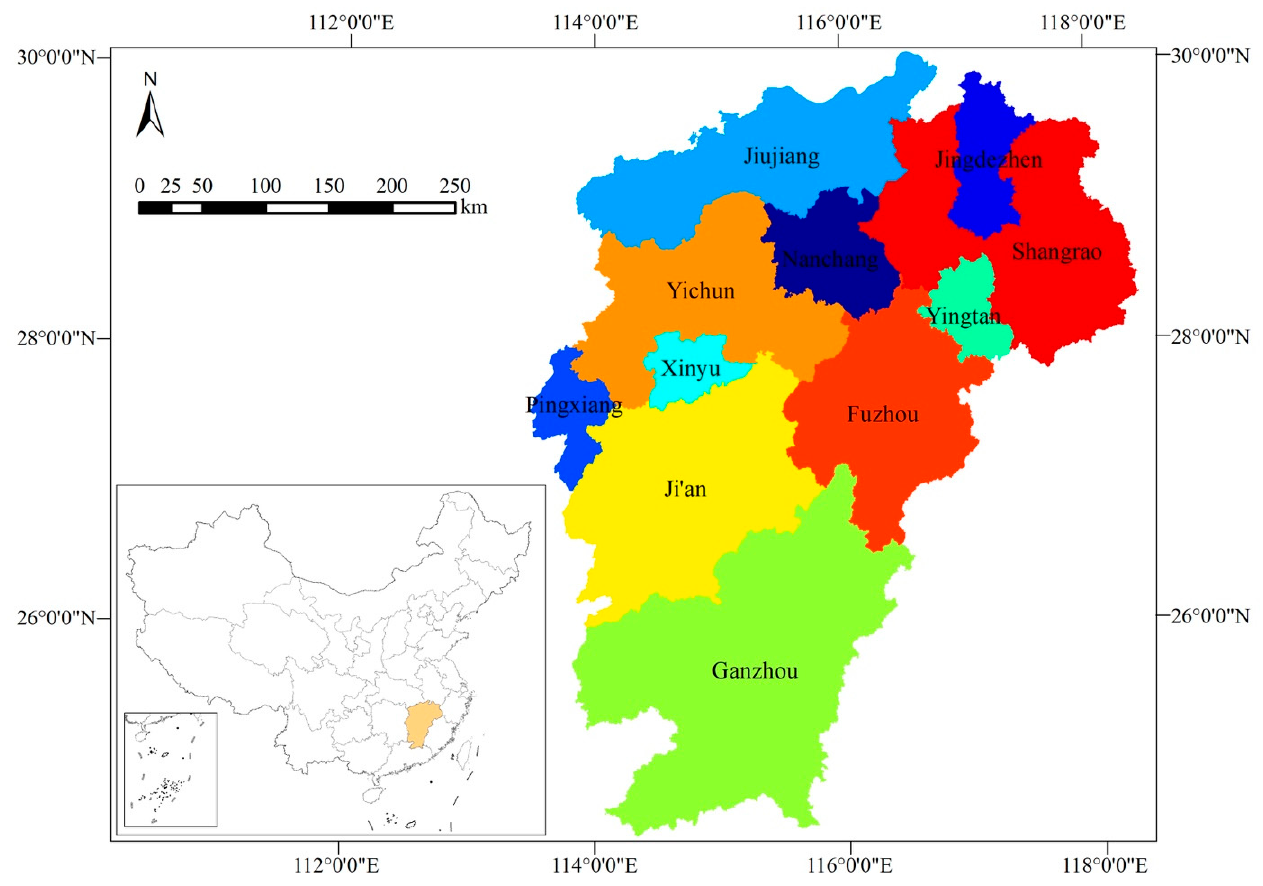
Figure 1. Study area: Jiangxi Province, China.